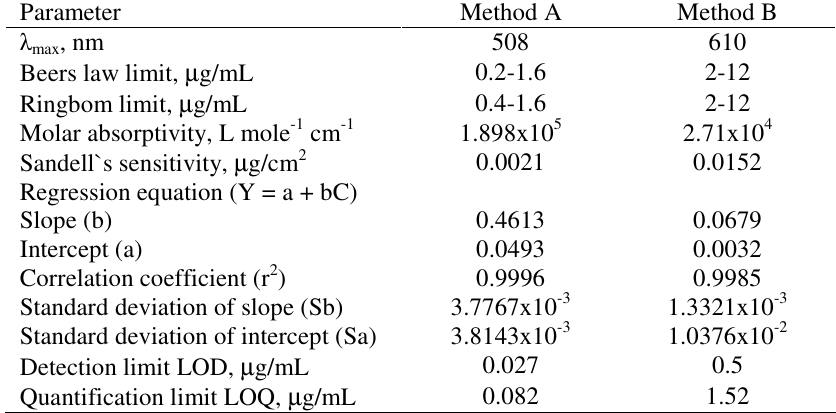
Table 1 Analytical and regression parameters of proposed